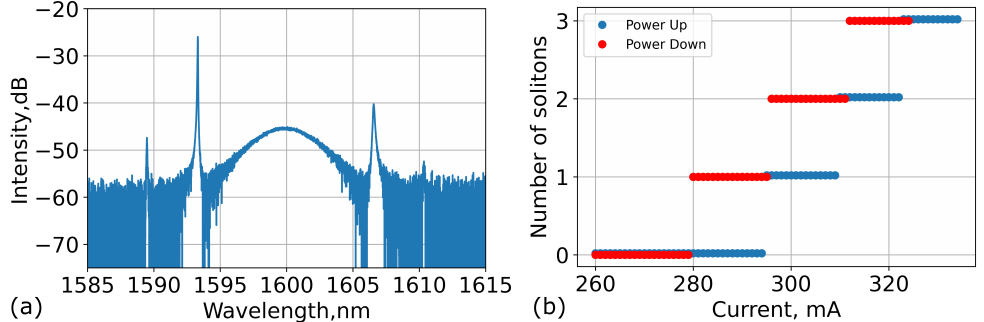
Figure 2. ( a ) Optical spectrum of the generated optical solitons. ( b ) Number of generated solitons as a function of the pumping laser diode current for different direction of the current